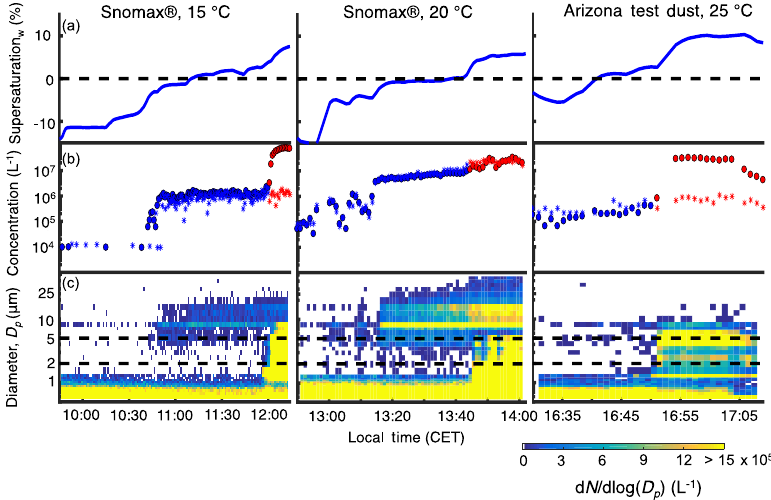
Figure 8. Application of depolarization ratio method on three CFDC runs. Aerosol composition and temperature are labeled in the title. (a) Time series of supersaturation with respect to water. (b) INP concentrations under normal (blue) and WDBT (red) conditions are shown for the traditional (circle) and new (asterisk) analysis methods. (c) The normalized number distributions of all particles detected by the CASPOL. Time is reported in local time (CET).